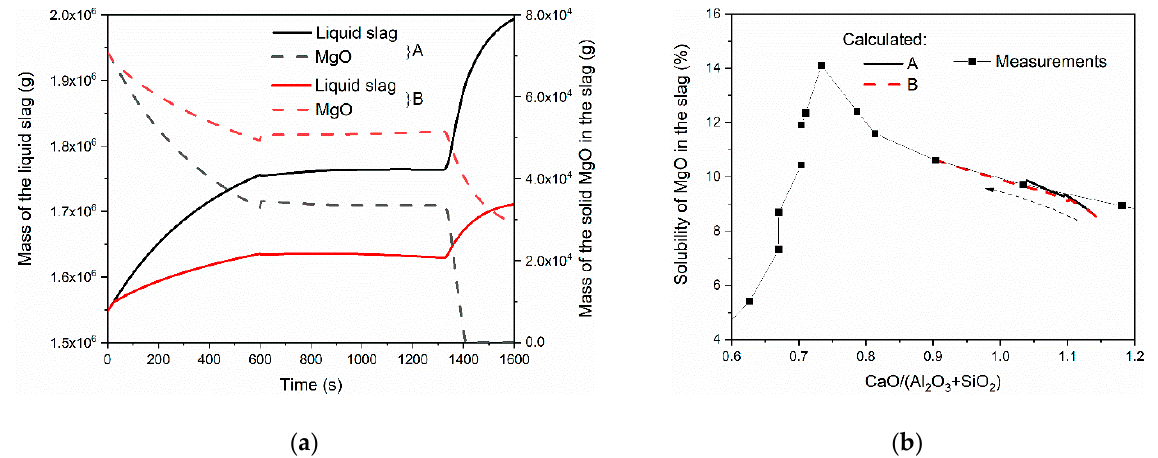
Figure 7. Comparing ( a ) the mass of slag phases and ( b ) MgO solubility in the liquid slag [21].